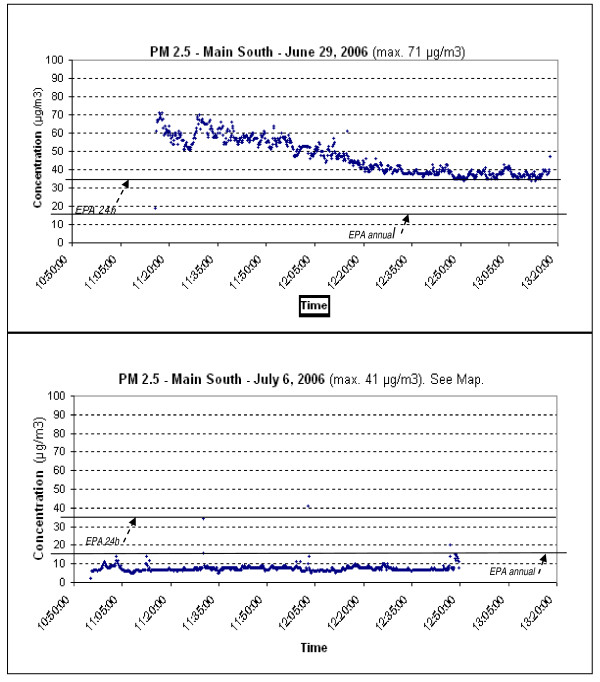
Time series of PM2.5. Plot of July 6 corresponds to Figure 2. Reference lines are NAAQS 24-h average standard (35 μg/m3) and annual average (15 μg/m3). While the sensor tends to overestimate actual levels - so direct comparisons with standards are inappropriate - the data may be a surrogate for actual levels.